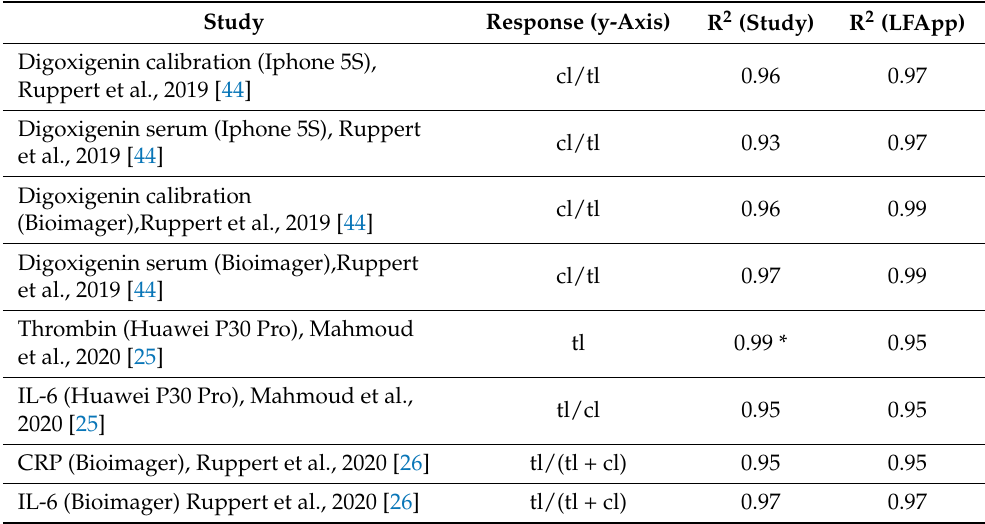
Table 1. Side-by-side performance comparison of the results of our system and the methods of other studies using R 2 goodness of fit. Study Response (y-Axis) R 2 (Study) R 2